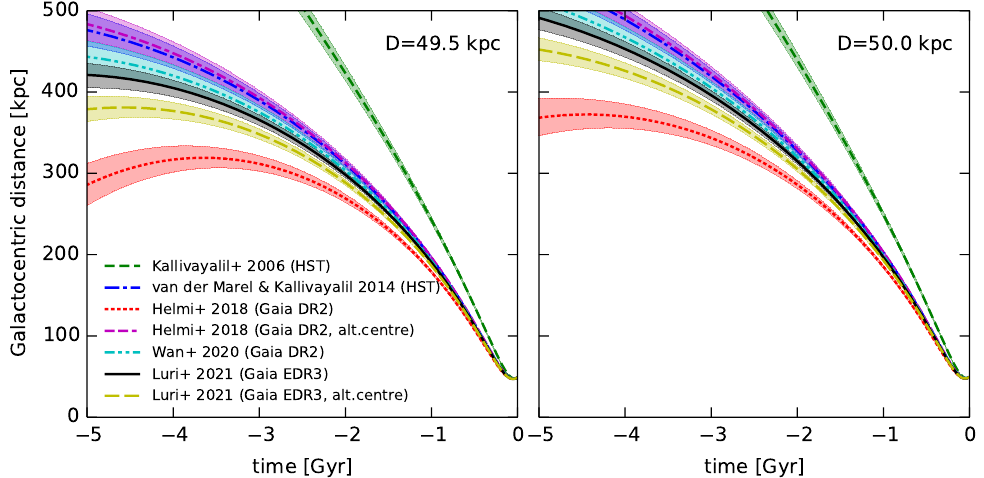
Figure 2. Past trajectory of the LMC for various choices of the present-day position/velocity. Different lines correspond to sky positions and PM from different studies listed in Table 2; shaded regions show the uncertainties associated with the PM and line-of-sight velocity (262.2 cases [39]). Left and right panels show the effect of changing the current distance by 1%, which is comparable to the difference in PM between studies and far exceeds the nominal PM uncertainty in each study. The LMC follows a test-particle orbit in the fiducial potential described in the text.